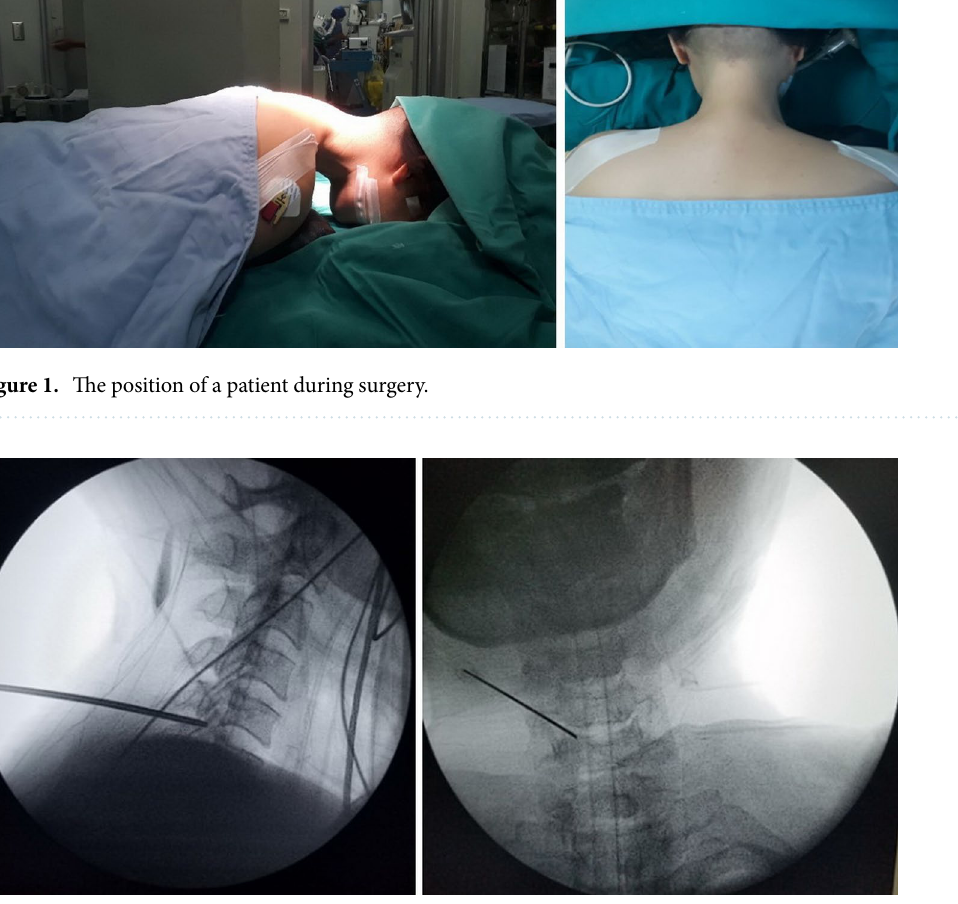
Figure 2. Under fluoroscopic control, the guide wires are inserted through the posterior cervical musculature with the tip directed to the operative disc